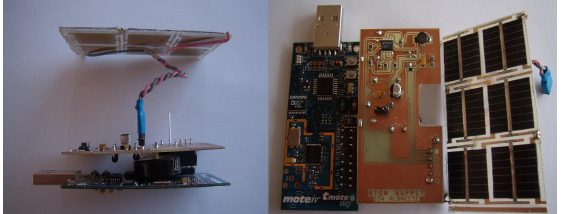
Figure 3. ATON I